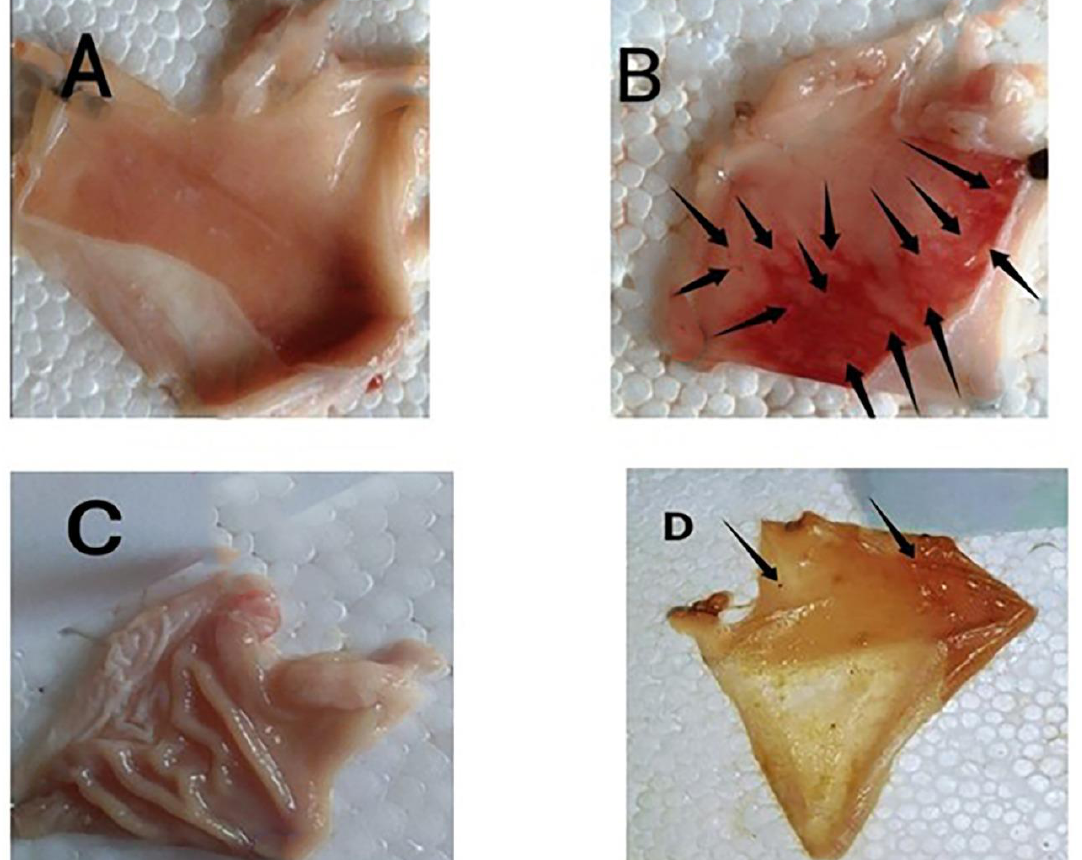
Figure 2. ( A – D ) Photos of rat stomachs. ( A ) (normal group), ( B ) (positive control group), ( C ) (cimetidine group), ( D ) (guava seed extract group). Effect of Guava seed extract on the gastric lesion severity (gross examination). ( A ) Control: intact gastric mucosa tissues; ( B ) indomethacin (ulcer): severe lesions are seen with extensive visible hemorrhagic necrosis of gastric mucosa; ( C ) cimetidine-treated rats: mild lesions of the gastric mucosa are observed compared to the lesions in indomethacin-induced ulcer rats; ( D ) guava seed extract-treated rats: nearly normal gastric mucosa tissues.